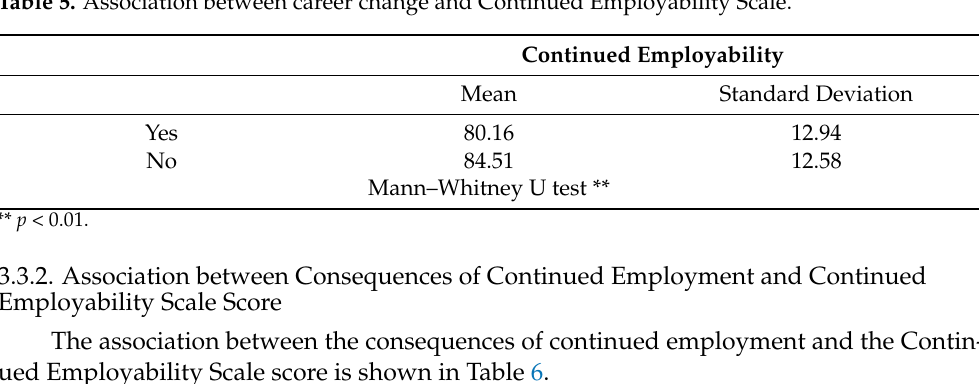
Table 5. Association between career change and Continued Employability